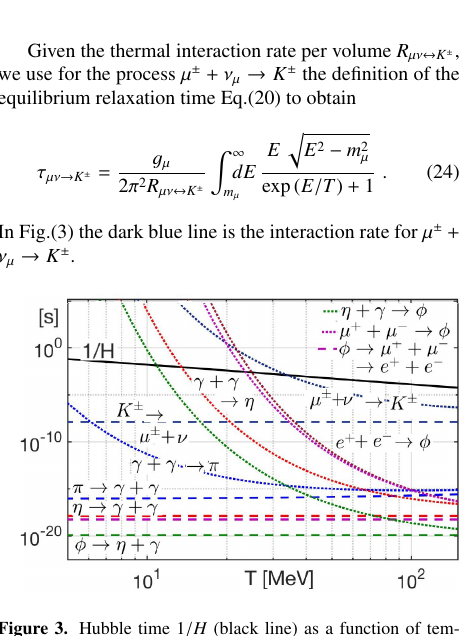
Figure 3. Hubble time 1 / H (black line) as a function of tem- perature is compared to leptonic and photonic relaxation reac- π (blue), γ + γ η tion times, see Eq.(20), for γ + γ ↔ ↔ φ (green), l + + l − φ (brown and purple), and (red), η + γ ↔ ↔ µ ± + ν µ K ± (dark blue line). The horizontal dashed lines are −→ the natural decay lifespans.